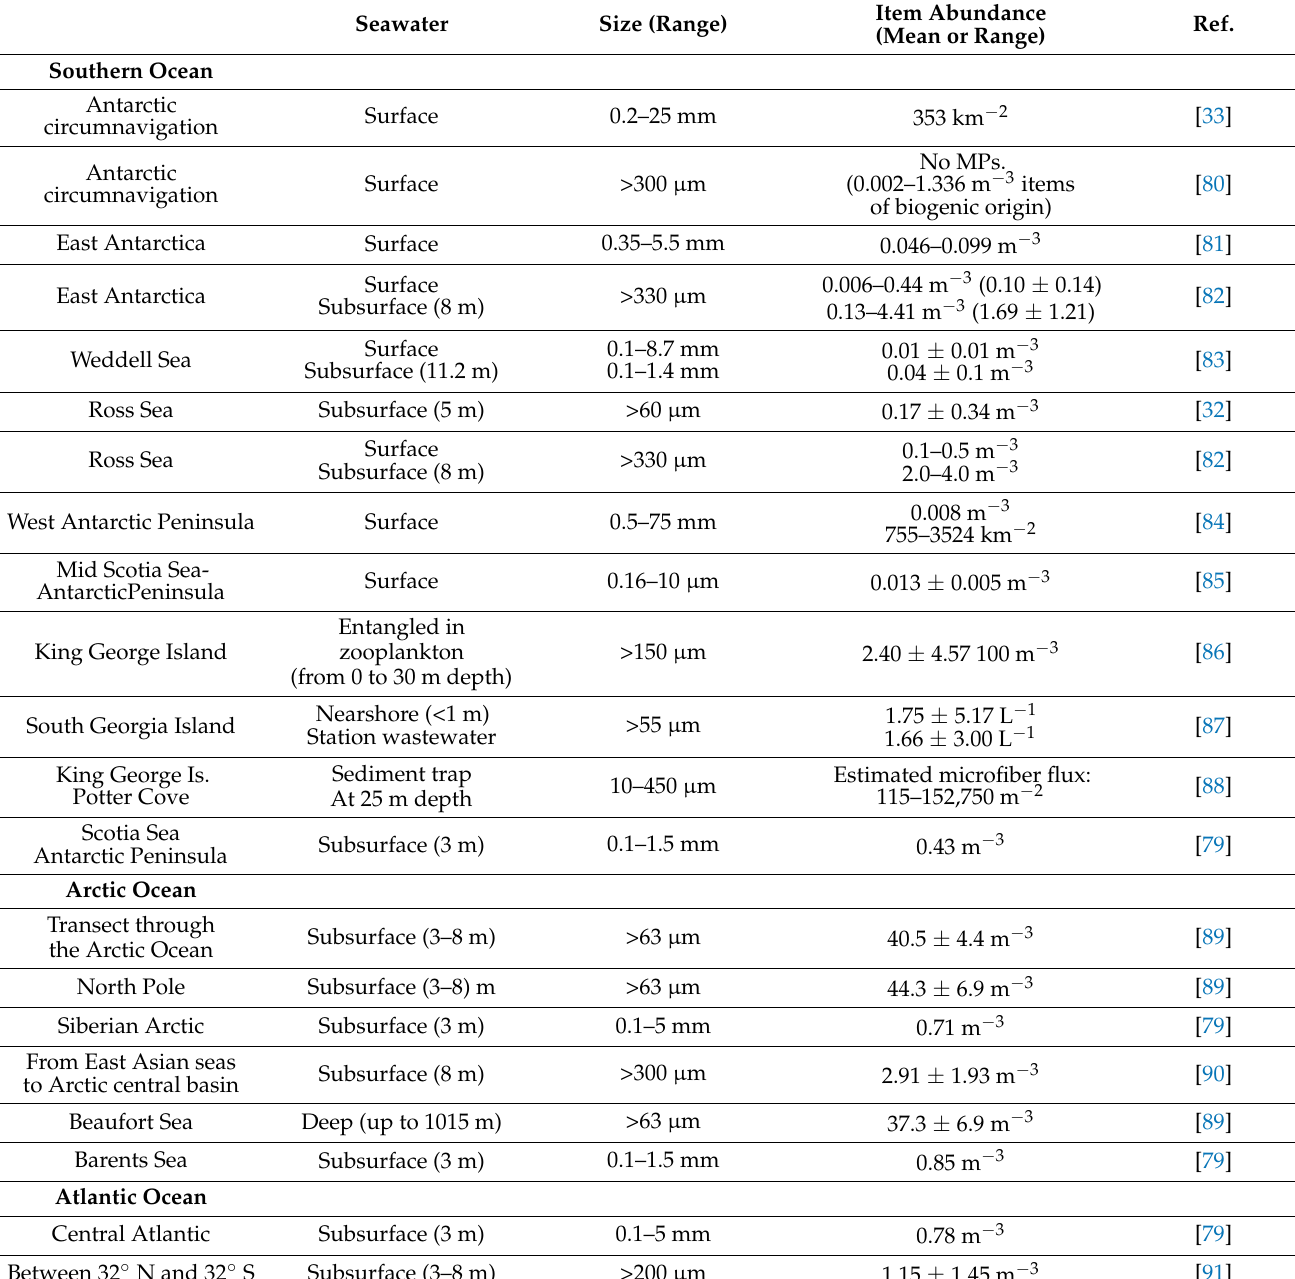
Table 1. Indicative values of microplastic abundance (obtained with different sampling and analytical methods) in seawaters from the Southern, Arctic and Atlantic